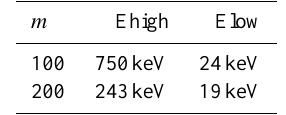
Table 1. Results of calculations of resonant high and low energies. m Ehigh Elow 100 750keV 24keV 200 243keV 19keV